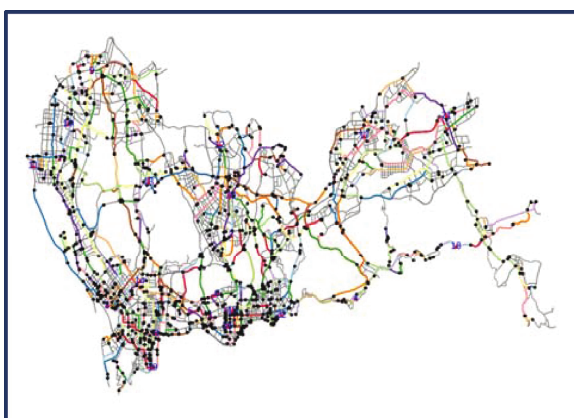
Figure 8: Path planning for large-scale EV users.